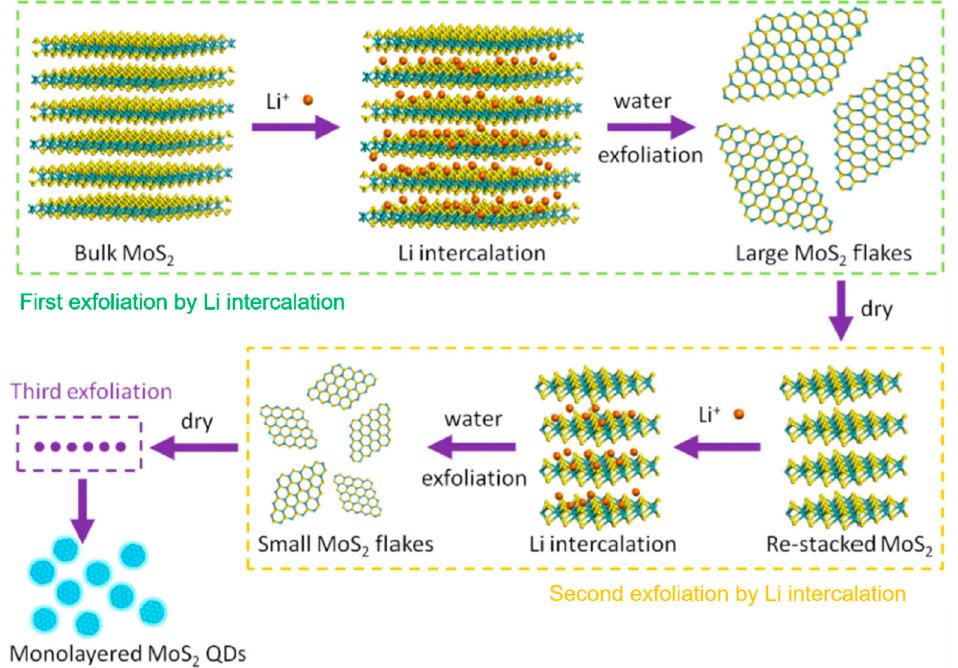
Figure 10. Schematic illustration of the preparation of monolayer MoS 2 quantum dots using multiple exfoliations with Li intercalation. Reproduced with permission from [70]. Copyright Elsevier B.V., 2015.